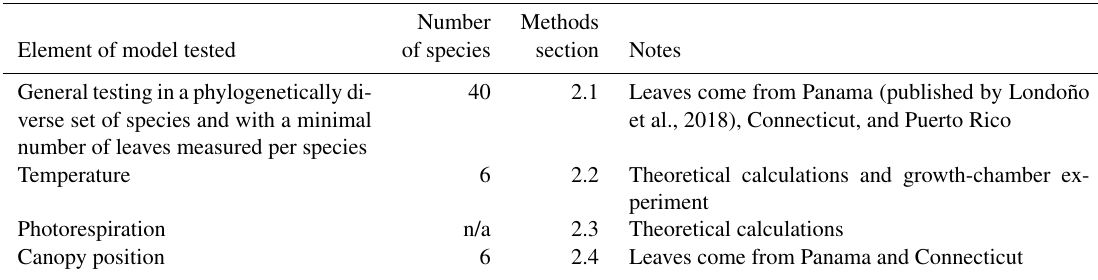
Table 1. Attributes of datasets used to test the Franks et al. (2014) model. Number Methods Element of model tested of species section Notes General testing in a phylogenetically di- 2.1 Leaves come from Panama (published by Londoño et al., 2018), Connecticut, and Puerto Rico 2.2 Theoretical calculations and growth-chamber